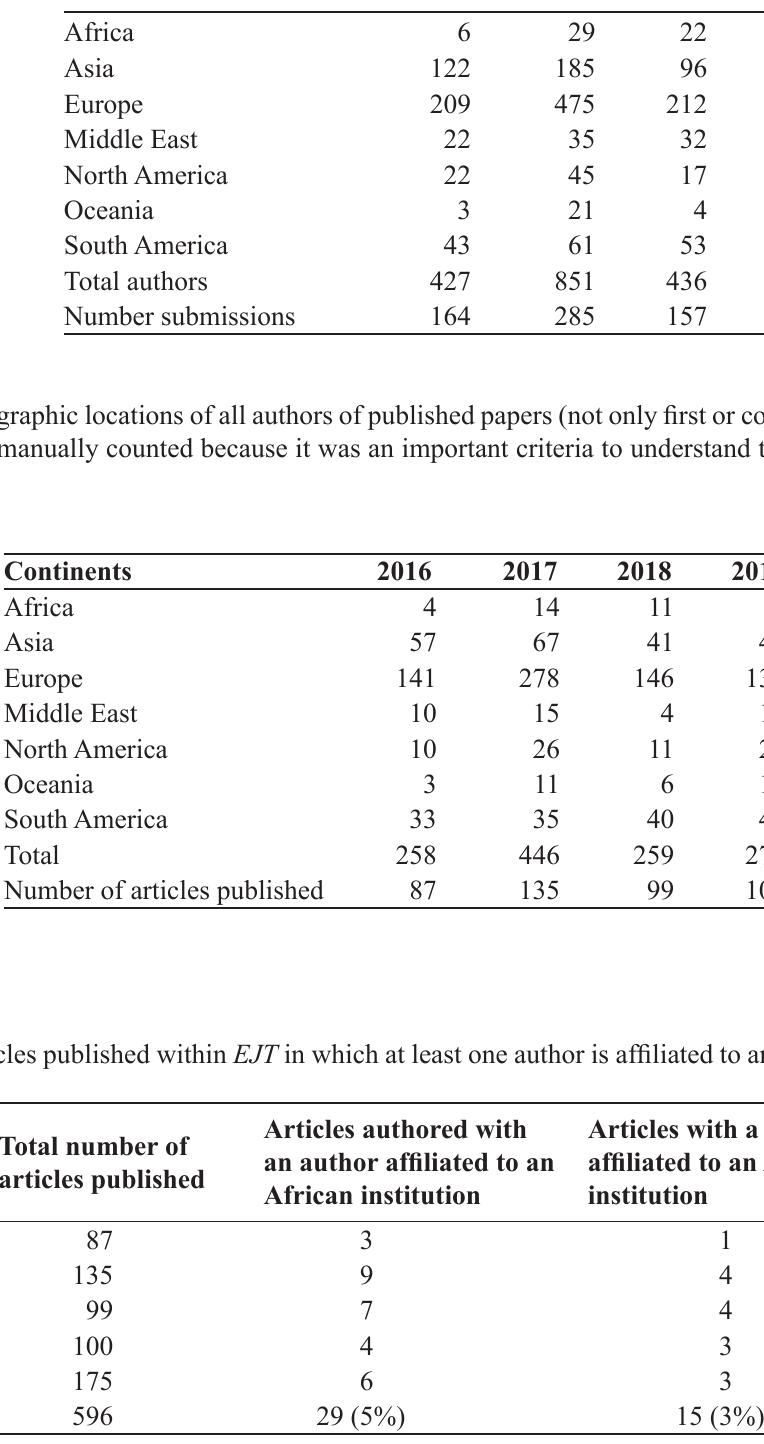
Table 2. Affiliation countries of authors of submitted papers. Figures manually counted for 2015 and 2016. In 2015, 164 papers were submitted, in 2016 285 papers were